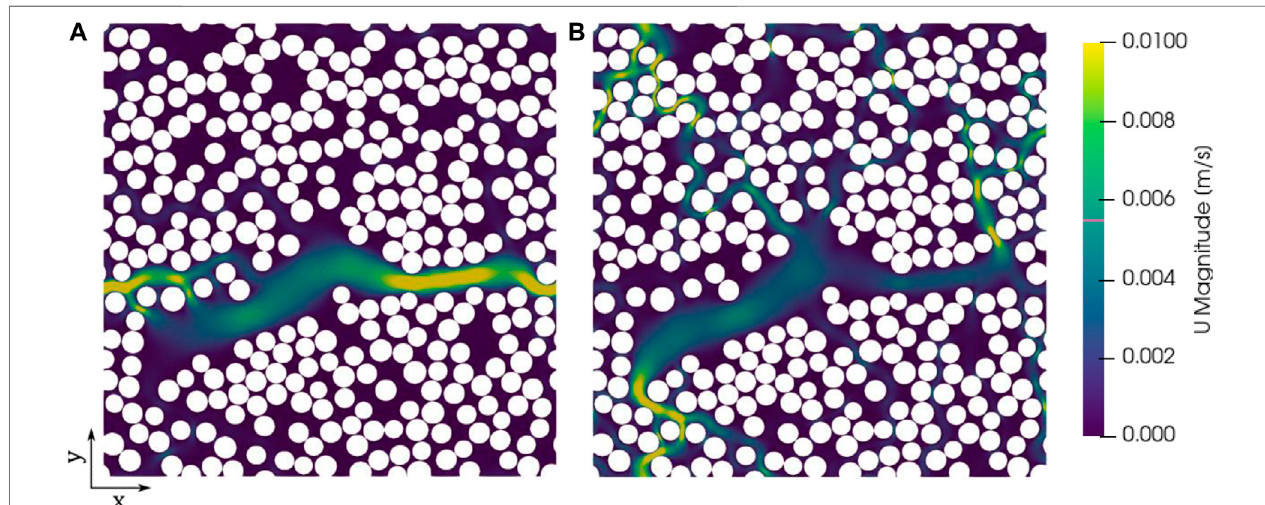
FIGURE A1 | Flow velocity results in (A) x-direction and (B) y-direction of one outlier with 50.06% fi ber volume fraction. The resulting transverse permeabilities in x-direction and y-direction are 2 . 47629 · 10 − 13 and 3 . 09254 · 10 − 14 , respectively.